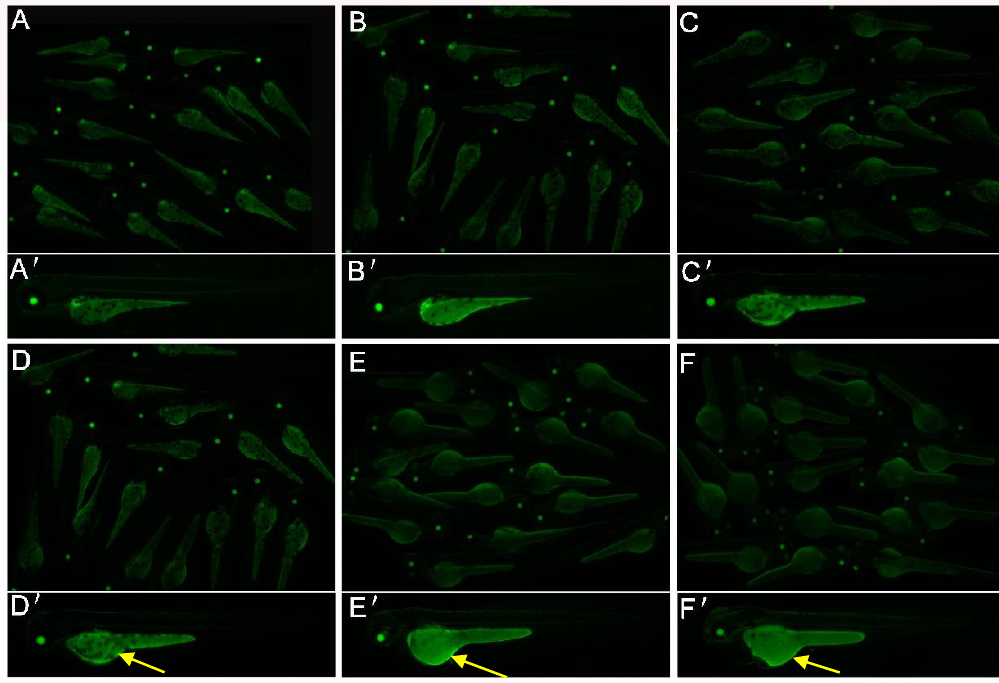
Figure 4. Yolk malabsorption in Tg(apop:GFP) larvae exposed to 2,4-DNT at 3 dpf. A : blank control; B : vehicle control (0.05 mL / L acetone); C : 2 mg / L 2,4-DNT; D : 4 mg / L 2,4-DNT; E : 6 mg / L 2,4-DNT; F : 8 mg / L 2,4-DNT. The yellow arrows indicate yolk sac accumulation. The pictures for A-F were taken with the stereomicroscope in 2.5 × magnification, and A’-F’ were in 3.5 × magnification.